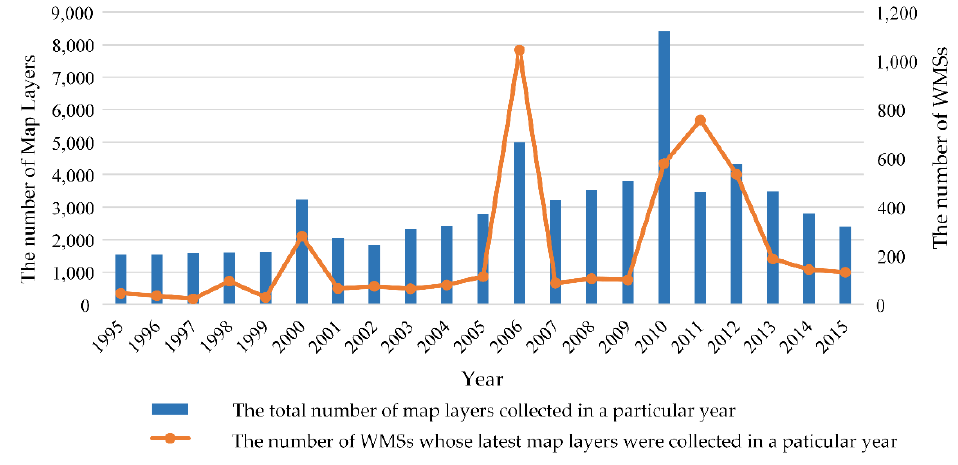
Figure 10. Yearly distribution of map layers and WMSs with current map layers.